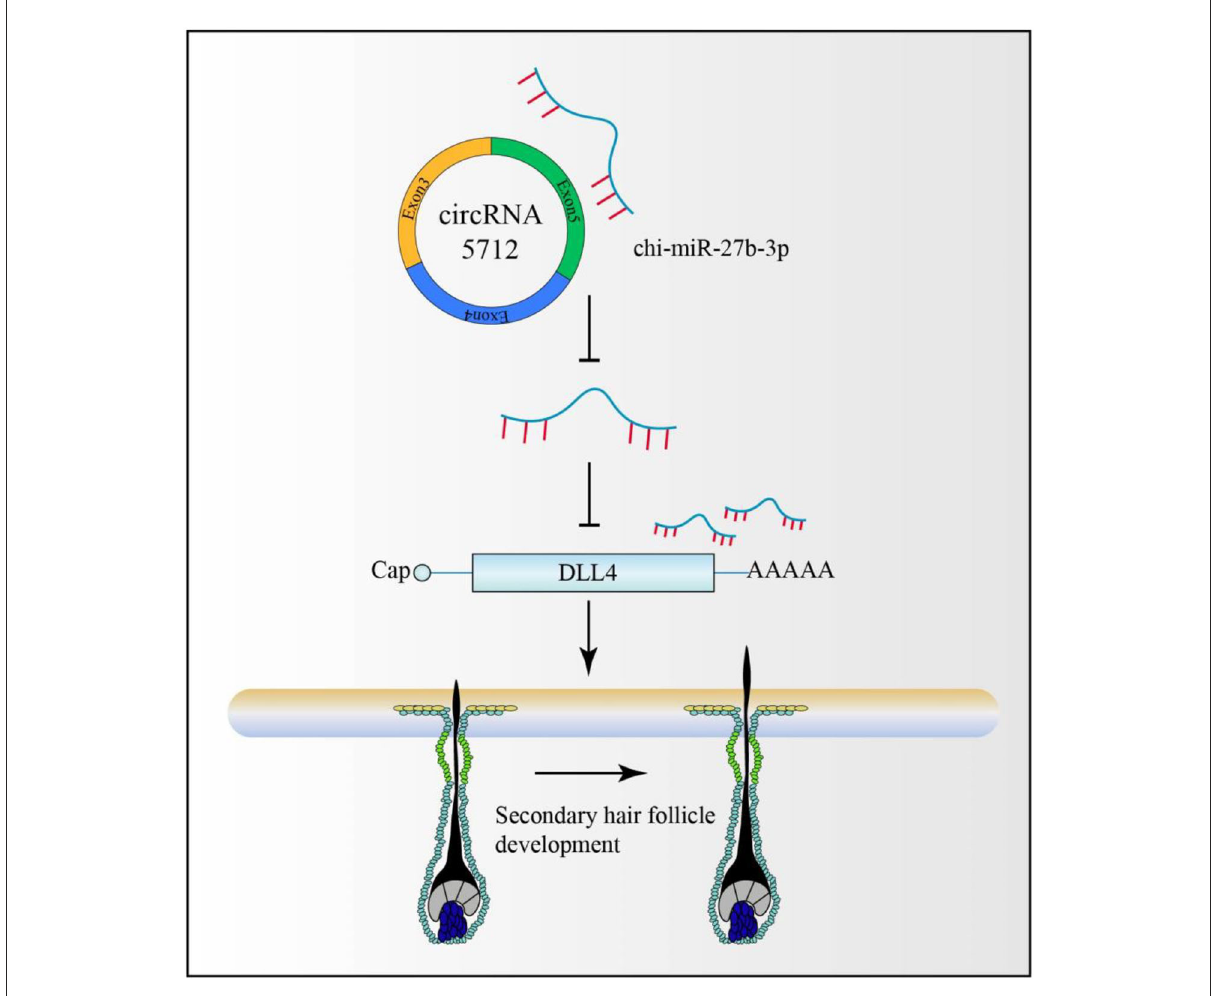
FIGURE11 circRNA-miRNA-mRNA-secondary hair follicle model.